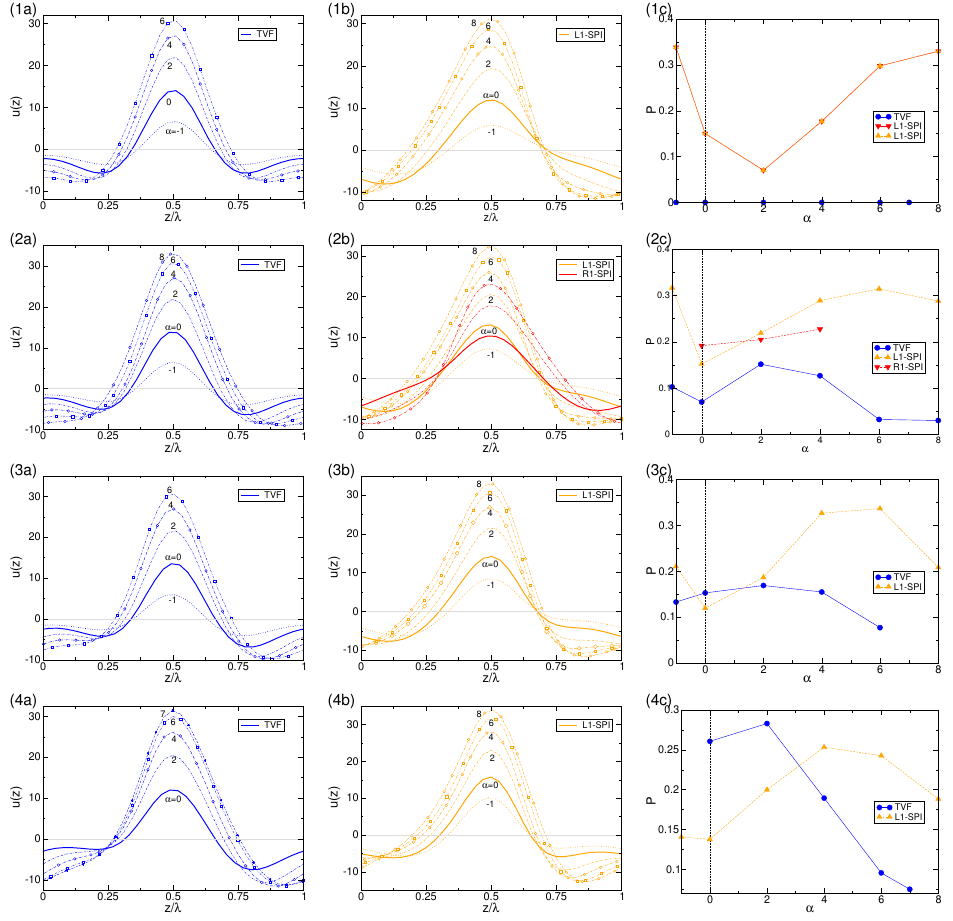
Figure 6. Flow dynamics for ( 1 ) Re = 0, ( 2 ) Re = 5, ( 3 ) Re = 10, and ( 4 ) Re = 20. Shown are axial profiles of the radial velocity u ( z ) at the midgap position for ( a ) TVF and ( b ) L1-SPI & R1-SPI and asymmetry parameter ( c ) P (see Equation (12)). In each case, the maximal radial outflow is chosen to lie at z = 0.5 λ . The L1-SPI [R1-SPI] is propagating in positive [negative] z direction (see also Figure